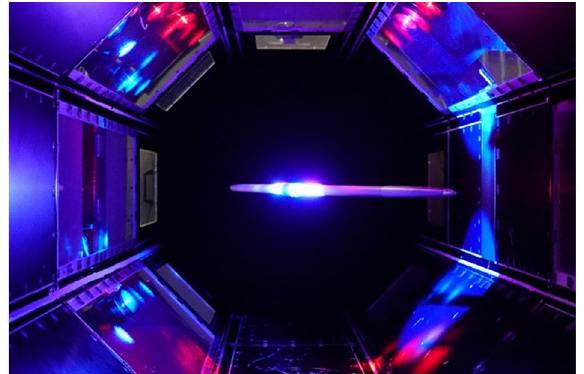
Figure 5. Javelin at 18° in the magnetic suspension and balance system.